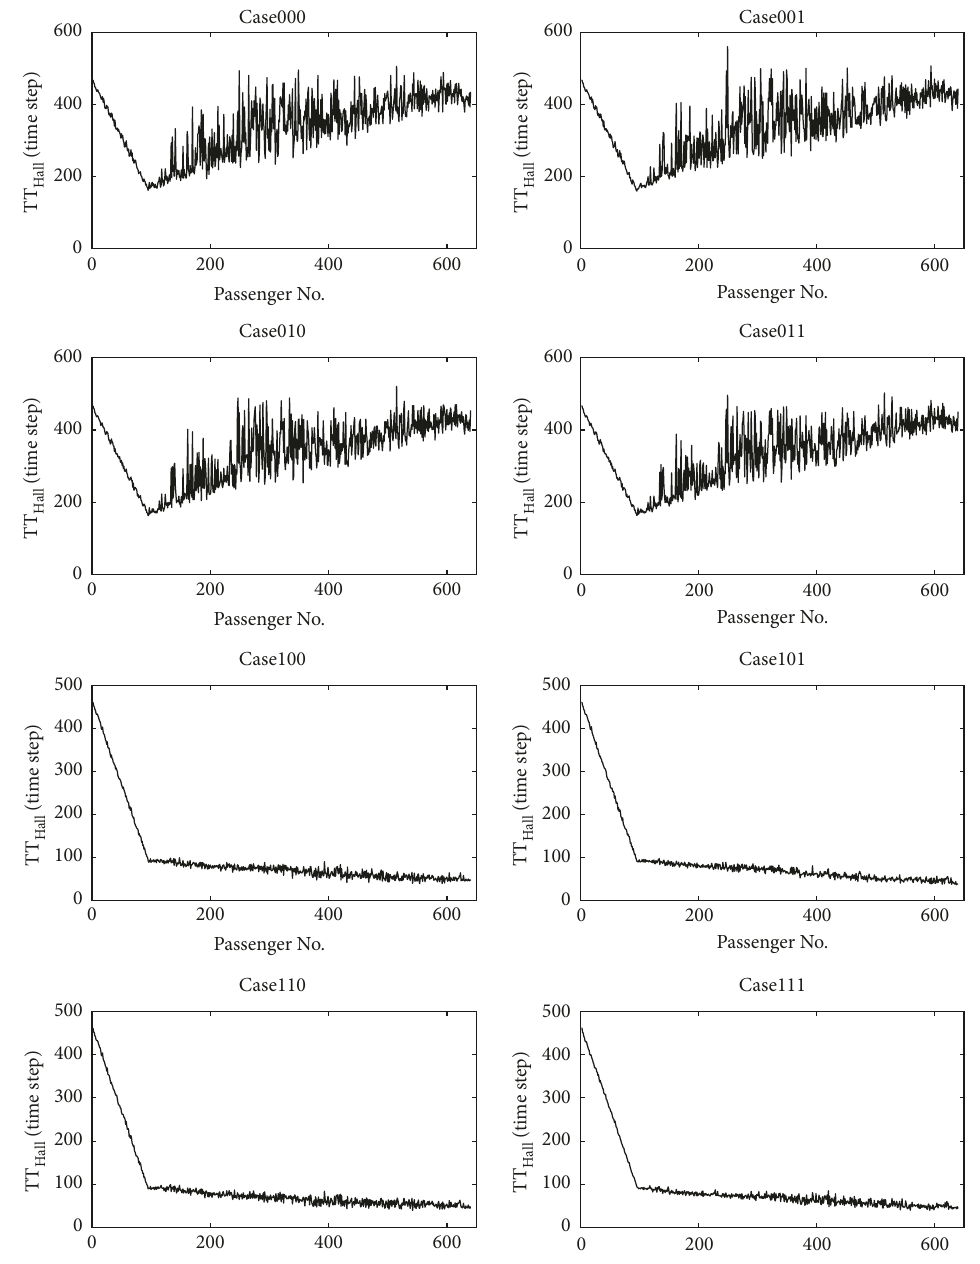
Figure 8: 𝑇𝑇 Hall under the eight